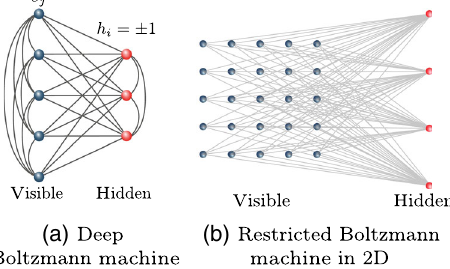
FIG. 2. (a) Boltzmann machines approximate a probability distribution by the Boltzmann weights of an Ising Hamiltonian on a graph including visible units (corresponding to the spins s j ) and hidden units h i , which are summed over. (b) Restricted Boltz- mann machines (here in 2D) only include interactions between the visible and the hidden